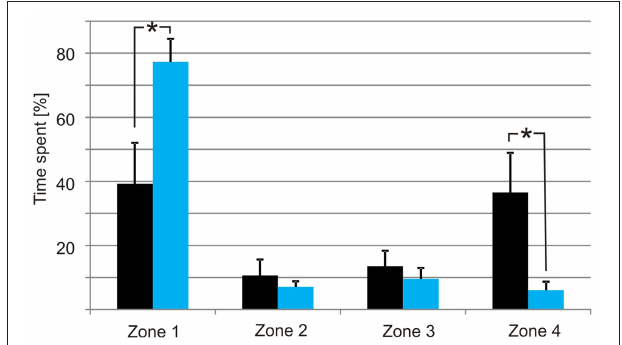
FIGURE 7 | Distribution of the medusae in darkness (black bars) and with bioluminescence (light blue bars). The tank was divided into four zones with zone 1 closest to the tank with P. noctiluca and zone 4 the furthest away. In darkness the medusae spend most time at the ends of the tank but with no significant difference between zone 1 and zone 4. When the bioluminescence of the algae is activated the medusae spend most of the time in zone 1. Asterisks indicate significant difference at the 0.05 level. Bars are means ± S.E.M., N =